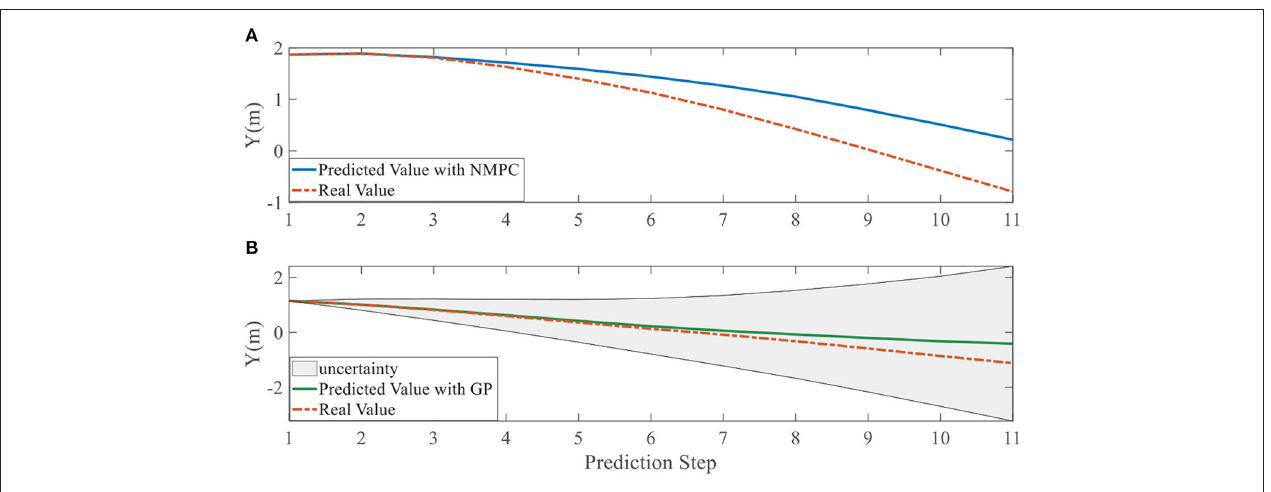
FIGURE 14 | Position Y evolution in right overtaking. (A) NMPC; (B) GPMPC.